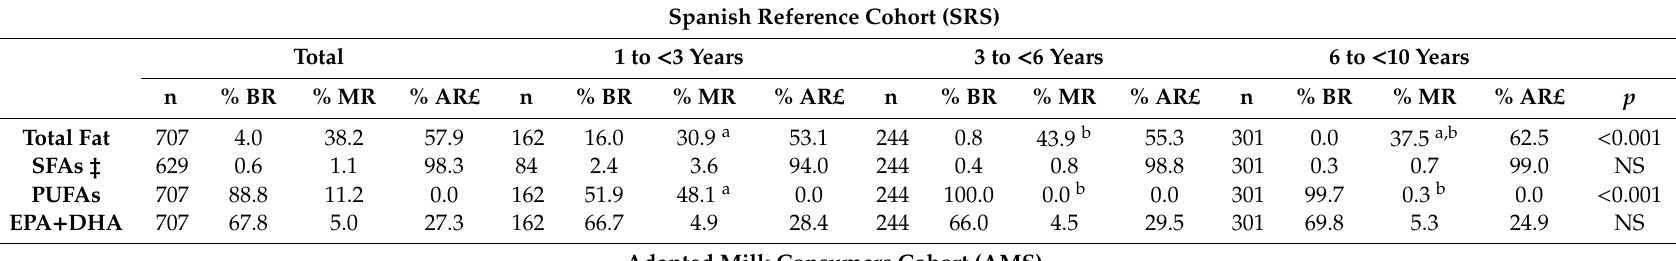
Table 8. Percentages of children meeting and not meeting Food and Agriculture Organization United Nations (UN-FAO) recommendations for main fatty acids by cohort and age categories for Nutritional Study in the Spanish Pediatric Population (EsNuPI) ( n = 1448 ‡ )